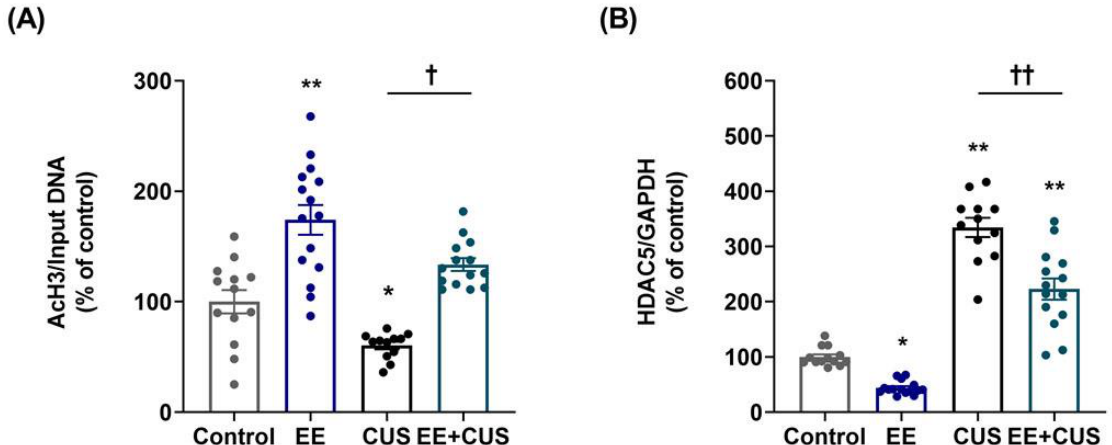
Figure 4. Effects of EE and CUS on the level of histone H3 acetylation at the p11 promoter and HDAC5 expression in the hippocampus. ( A ) Chromatin immunoprecipitation (ChIP) assays were performed to measure the level of acetylated histone H3 (AcH3) at the p11 promoter in the hippocampus using an antibody to AcH3. Data were normalized to input DNA. ( B ) The HDAC5 mRNA level in the hippocampus was measured by qRT-PCR. All quantities were normalized to GAPDH. Data are expressed as values relative to the control group using the 2 − ∆∆ ct method. Data represent mean ± SEM expressed as a percentage of the control group. * p < 0.05 vs. control group; ** p < 0.01 vs. control group; † p < 0.05 vs. CUS group; †† p < 0.01 vs. CUS group. n = 12–15 animals/group.